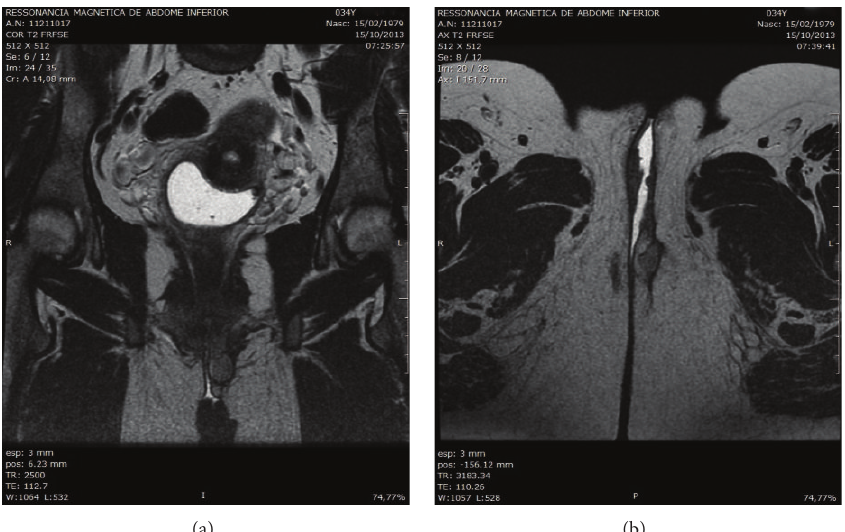
Figure 1: (a) Coronal and (b) axial MRI images with a 2.4×2×1.4 cm size soft tissue mass, in the left labia majora, and no pelvic and inguinal lymphadenopathy.